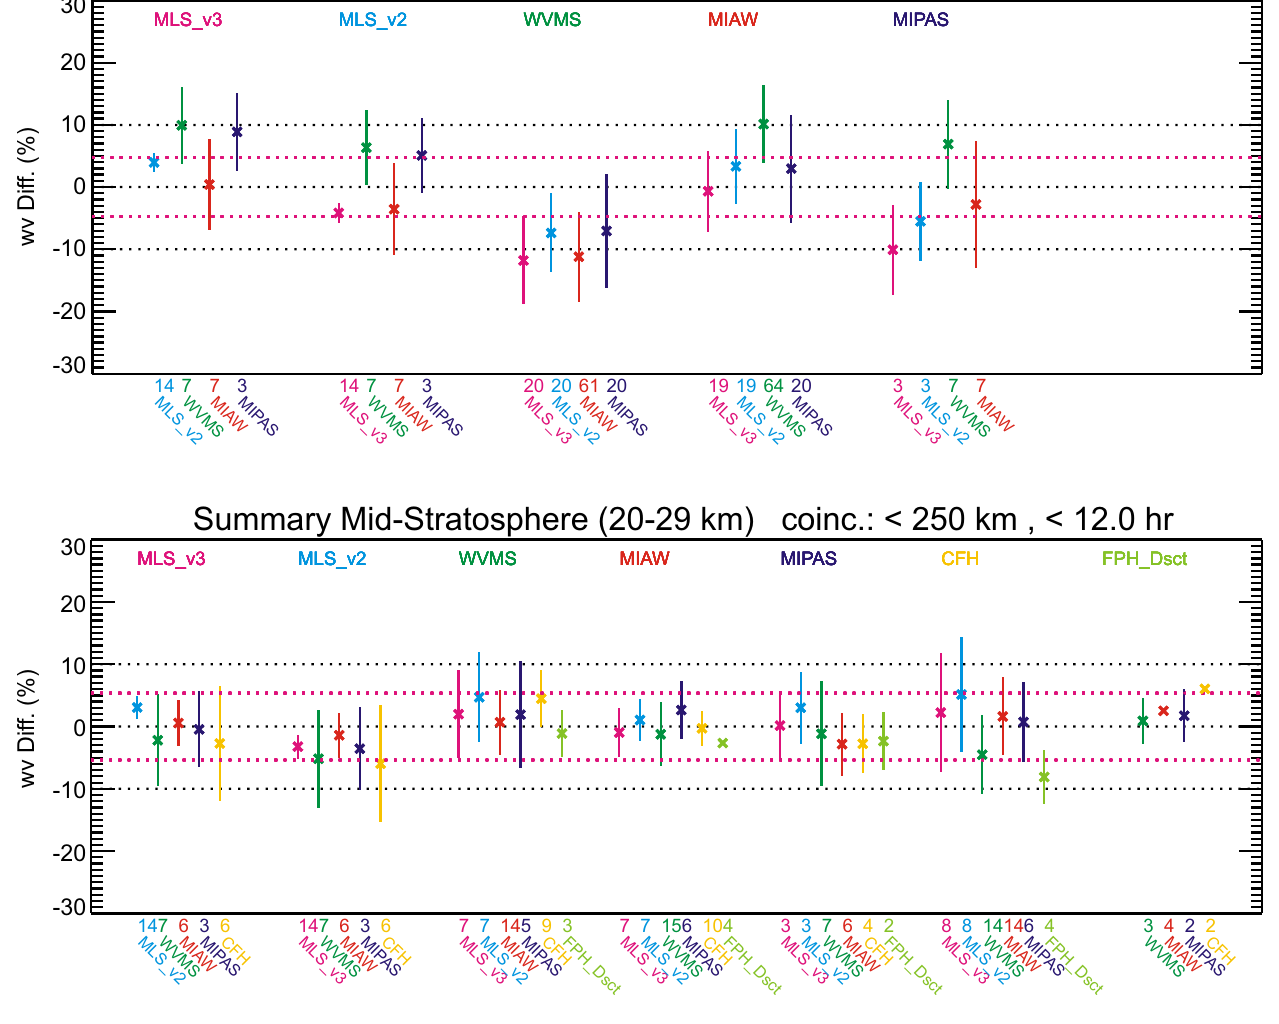
Fig. 18. Same as Fig. 16, but for the mid- (bottom) and upper (top) stratosphere. The top panel of this figure (lower stratosphere) appears to be the most interesting one. The dry bias of the uncorrected RS92 mentioned before is obvious here (between − 30 % and − 60 % with respect to all other instruments). Note that the measured water vapor standard deviation is represented by two horizontal pink dotted curves near ± 10 %. The posi- tion of the symbols with respect to these lines, as well as the size of the vertical bars, provides important insight on how representative the measurements are. For example, the best agreement and smallest spread of the differences is seen when comparing the CFH and NOAA-FPH (short, yellow segment on the far left of the top panel). This confirms that the frost-point technique remains the most accurate in this region. Another interesting example is CFH vs. TMW (red symbol and segment on the far left of the top panel). The mean difference is very small ( − 3 %), but the spread is larger than that just discussed. This can be explained by the